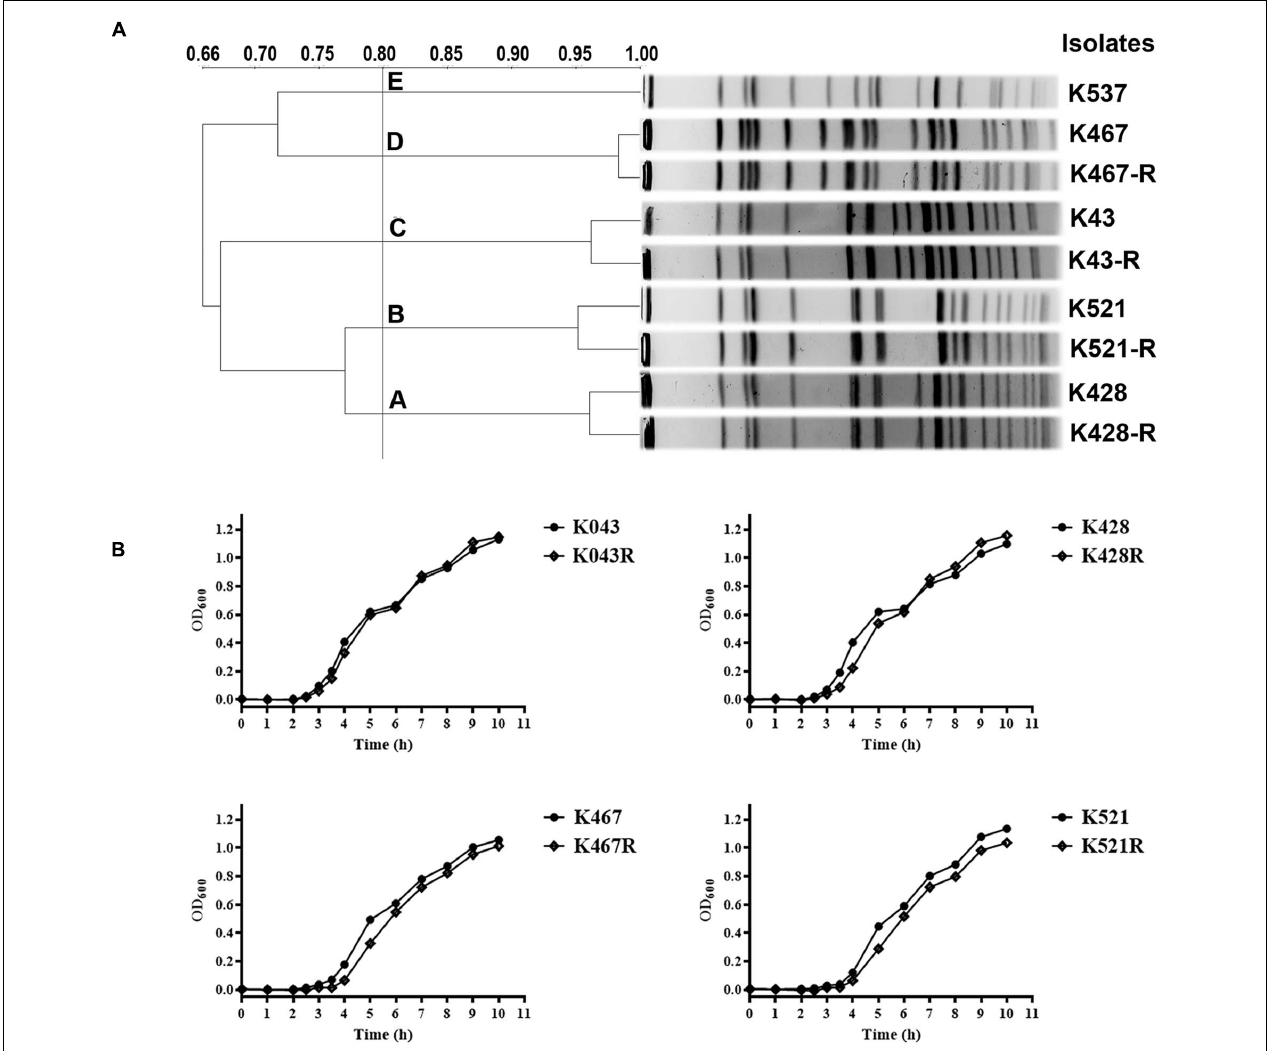
FIGURE 1 | (A) Pulsed-field gel electrophoresis (PFGE) analysis of five representative carbapenem-resistant Klebsiella pneumoniae (CRKP) clinical isolates and their resistance-induced descendants; (B) Growth dynamics of four resistance-induced strains and their parental clinical isolates.